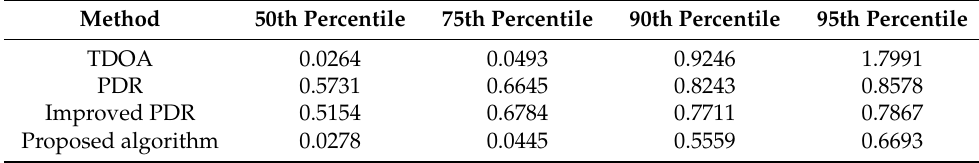
Table 7. Comparison of quantiles of error with different algorithms (m) (Third